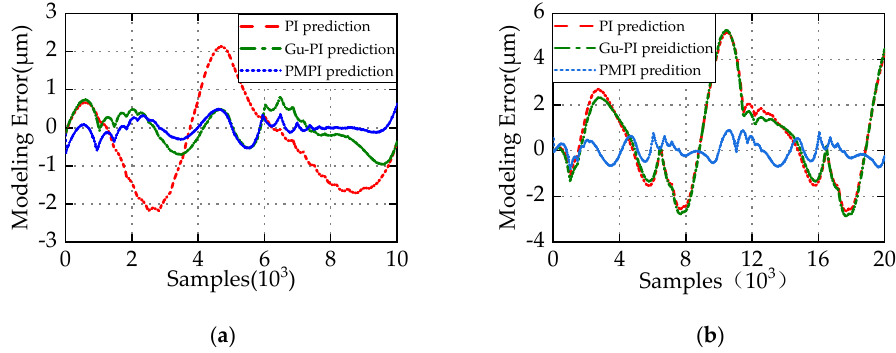
Figure 12. Two cases of comparative experiment. ( a ) Case 1: the initial loading curve is not considered; ( b ) Case 2: the initial loading curve is considered.